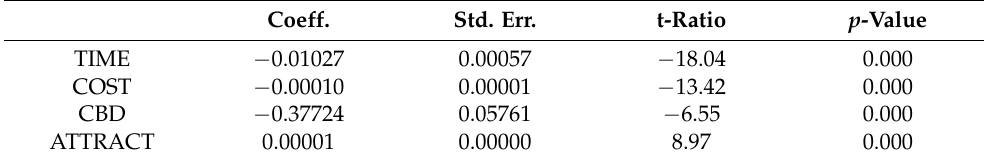
Table 3. Estimated parameters of mode and destination choice model (ABM).